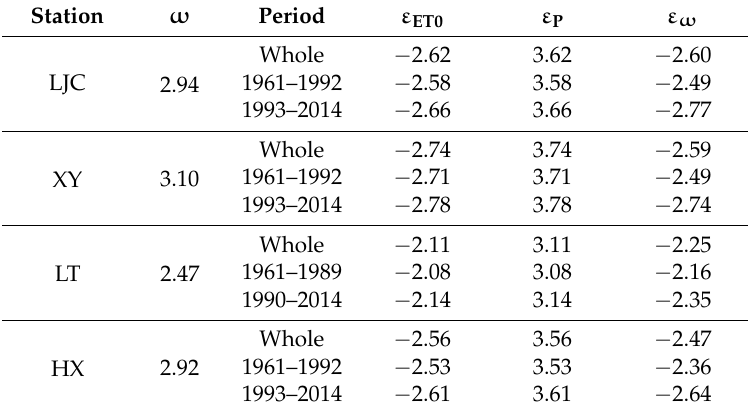
Table 2. Elasticity coefficients of runoff to climate variability and land surface change; the best calibration value of ω